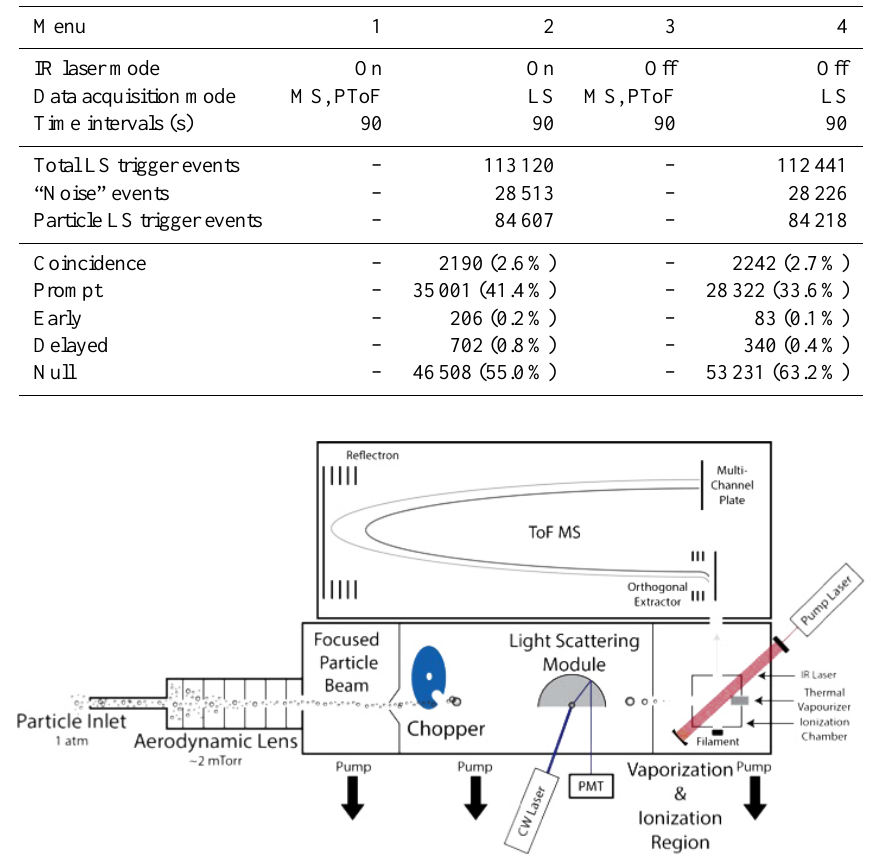
Figure 1. A simplified schematic of the SP-AMS equipped with a light scattering module (LS-SP-AMS) for ensemble measurements and single particle